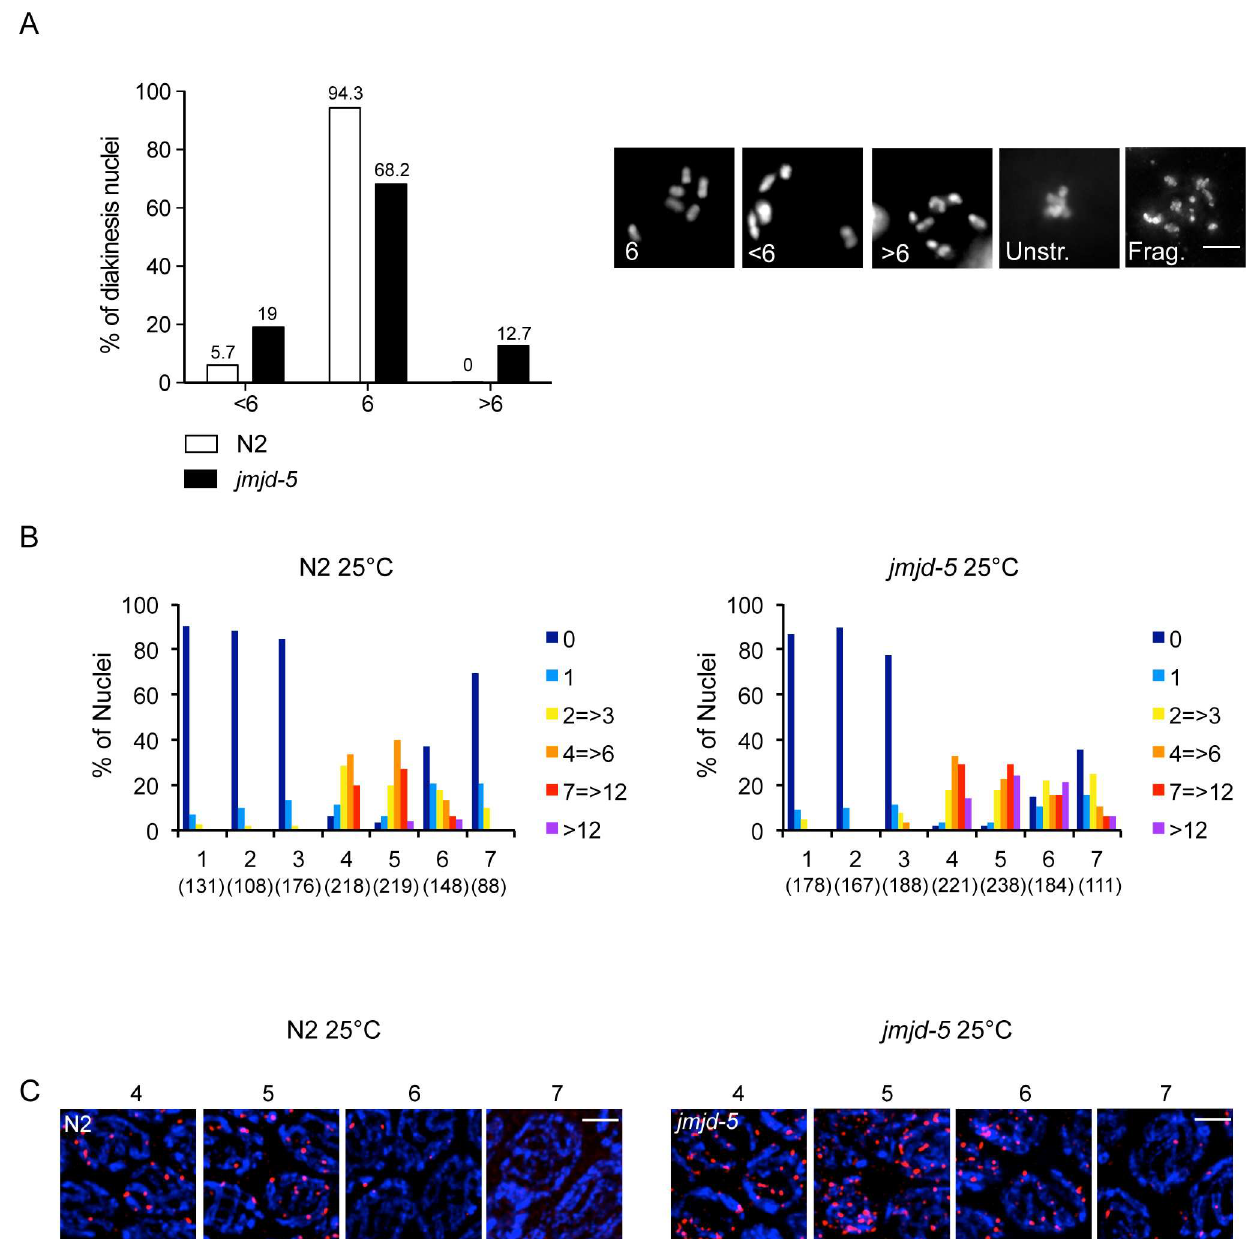
Fig 4. Role of jmjd-5 in meiotic homologous recombination. (A) Left. Quantification of DAPI-stained bodies at diakinesisin N2 and jmjd-5 mutants, grown at 25˚C for five generations. Nuclei were dividedin three classes based on the number of DAPI-stained bodies/nucleus, presented in the x-axis. The y-axis representsthe percentage of nuclei in each class. Numbers of nuclei scored were 122 for N2 and 110 for jmjd-5(tm3735) . Right: representative images of DAPI-stained nuclei at diakinesisin N2 and jmjd-5(tm3735) mutants grown at 25˚C for five generations. The numberwithin each panel indicatesthe number of DAPI-stained bodiesdetected. Unstr: Unstructured chromosomes, Frag: Fragmented chromosomes. Scale bar 5 μ m. (B) Histogramsshowingthe quantification of RAD-51 foci in germlines extracted from N2 (left) and jmjd-5(tm3735) (right) animalsgrown at 25˚C for five generations.Numbers in parenthesisindicate the numberof nuclei analyzed.(C) Representative images of RAD-51 (red) and DAPI (blue) staining in dissected germlines of N2 (left) and jmjd-5(tm3735) (right) grown at 25˚C for five generations.Nuclei from zones 4, 5, 6 and 7 are shown. In (A) and (C) each panel shows a projectionof multiplez-stacks (0.2 μ m spacing)of the entire nucleus.100X magnification, scale bar 2 μ